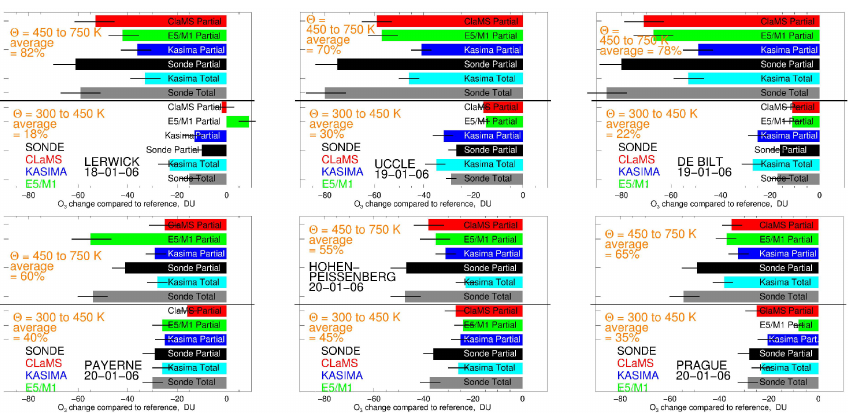
Fig. 15. Integrated ozone change between 2 = 300 and 450K, and between 2 = 450 and 750K at the six stations; sonde measurements in black and grey, KASIMA in blue and light blue, E5/M1 in green, CLaMS in red; Partial results for consistent common range ( 2 = 350 to 700K); sonde and KASIMA also available for Total column between 2 = 300 and 750K; average relative weights in % of the two altitude compartments to the total ozone decrease also given. Table 5. Integrated ozone change between 2 = 300 and 450K, and between 2 = 450 and 750K, as displayed in Fig. 15 for the six stations; values given for day of observed minimum total ozone column; P: results for the consistent common range ( 2 = 350 to 700K); T: sonde and KASIMA results also for the total column ( 2 = 300 to